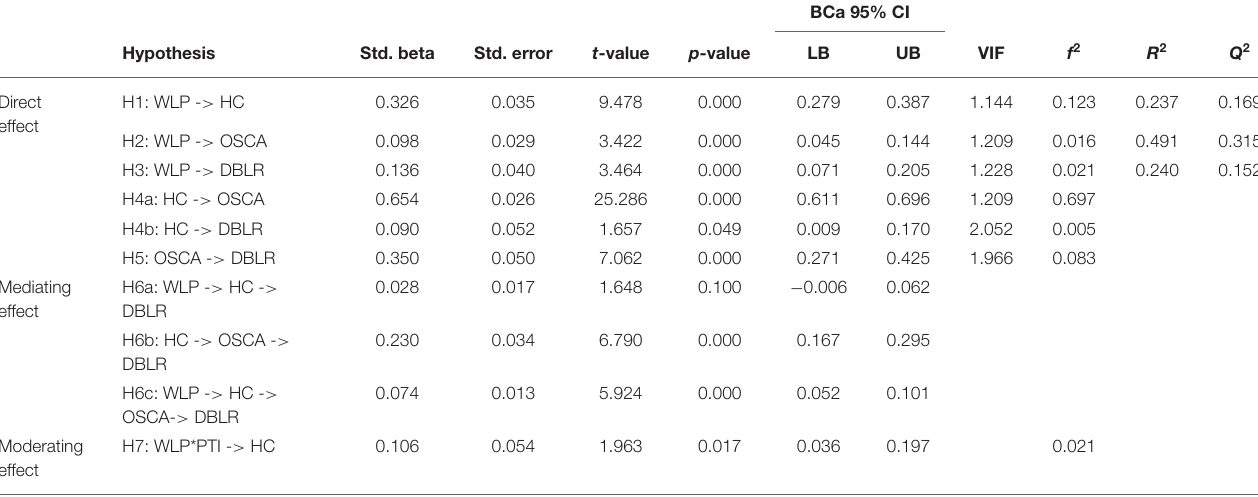
TABLE 4 | Structural model results.